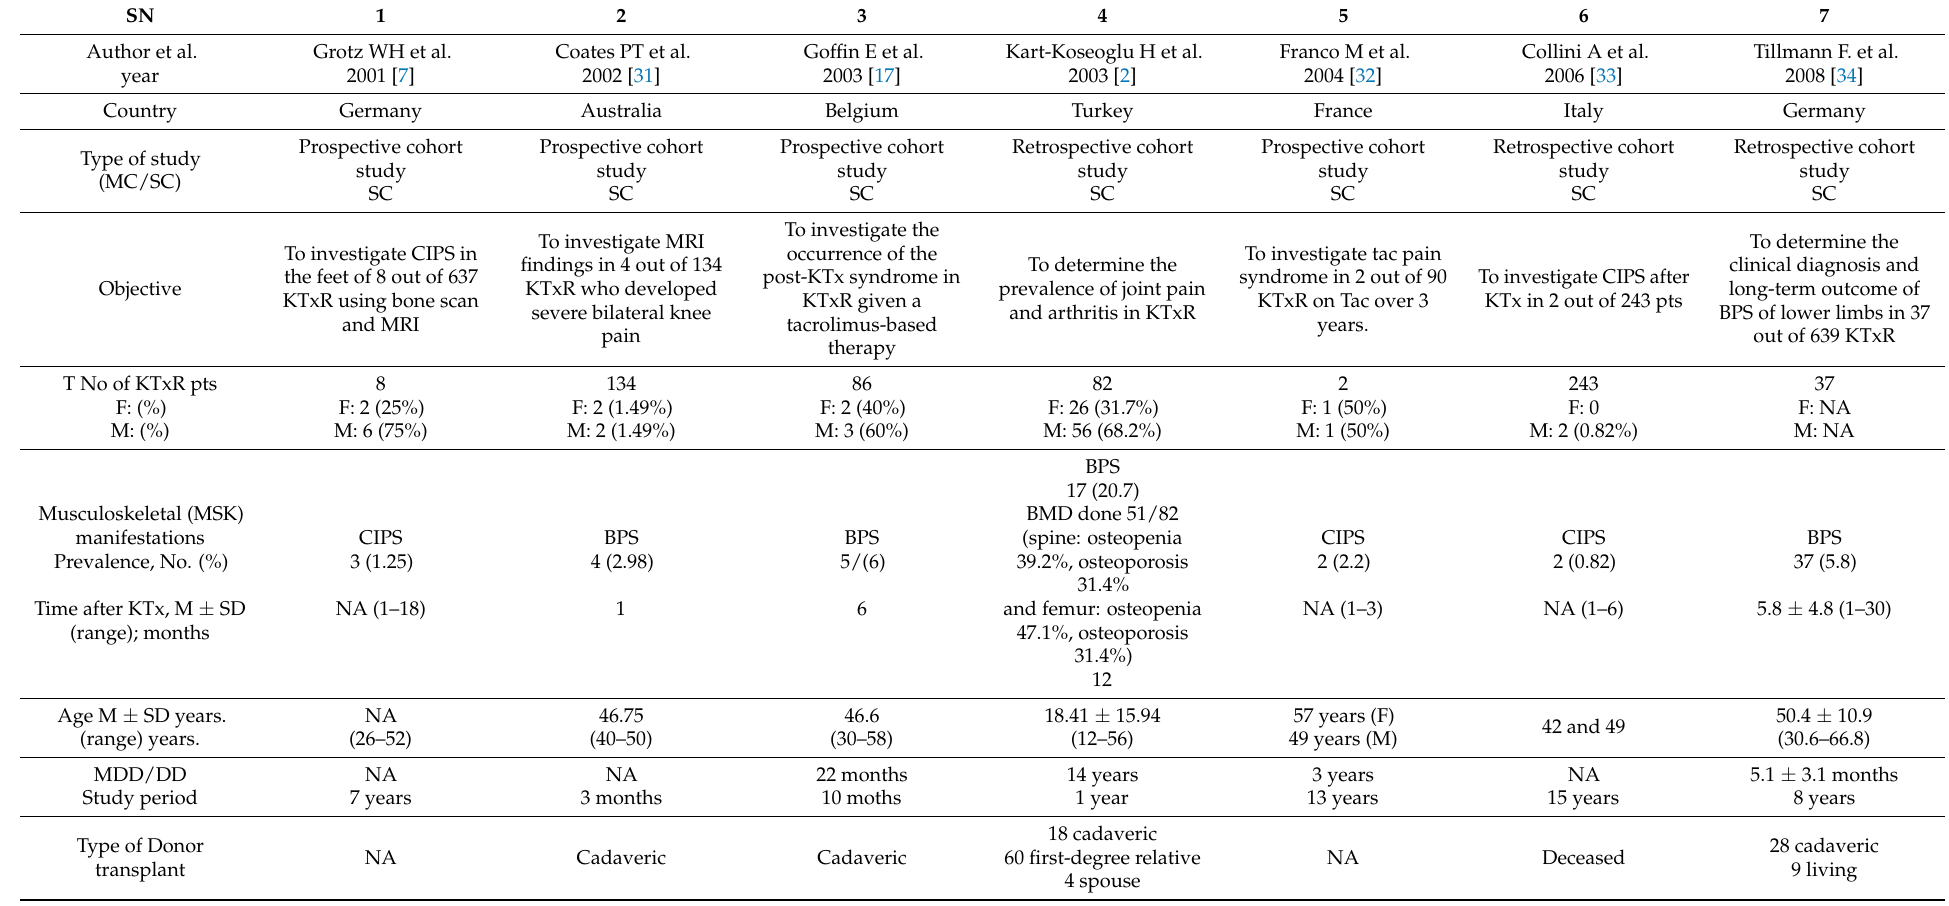
Table 1. Prevalence of Bone pain syndrome (BPS) in adult post kidney transplant recipients (KTxR) included in this systematic